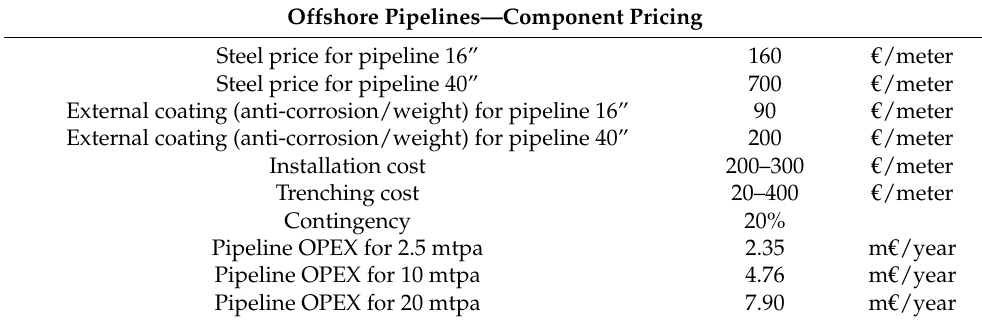
Table 11. Offshore pipeline component pricing, data is analyzed and summarized from [21].